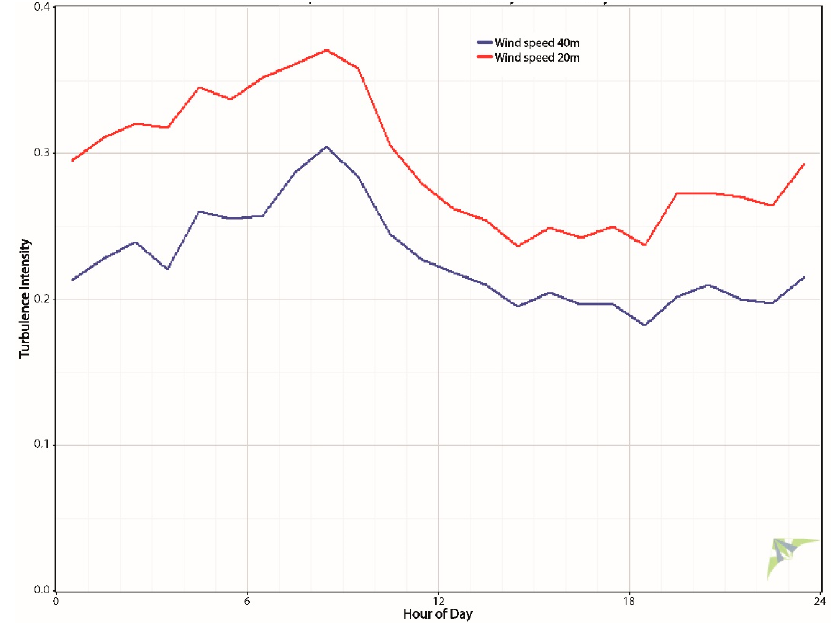
Figure 12. Wind turbulence as a function of time of day. Source: generated by the software.